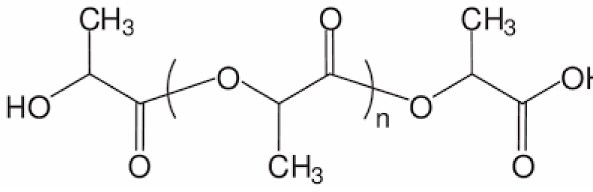
Figure 5. PLA chemical